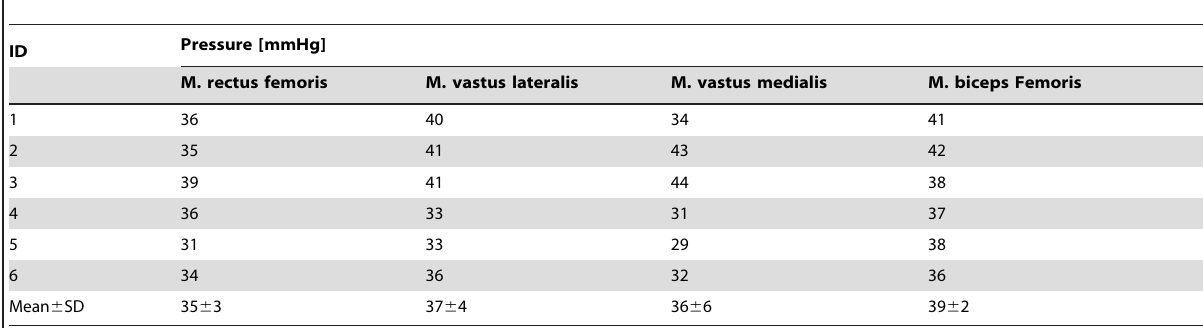
Table 2. All subjects’ pressure of the shorts at different areas of the thigh.